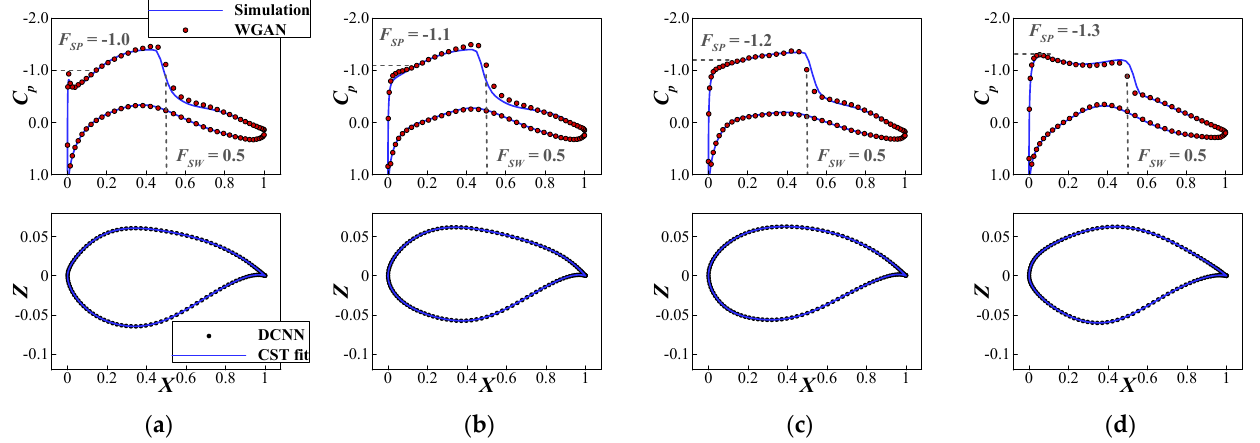
Figure 12. Typical inverse design results produced by different suction peak features: ( a ) F SP = −1.0,